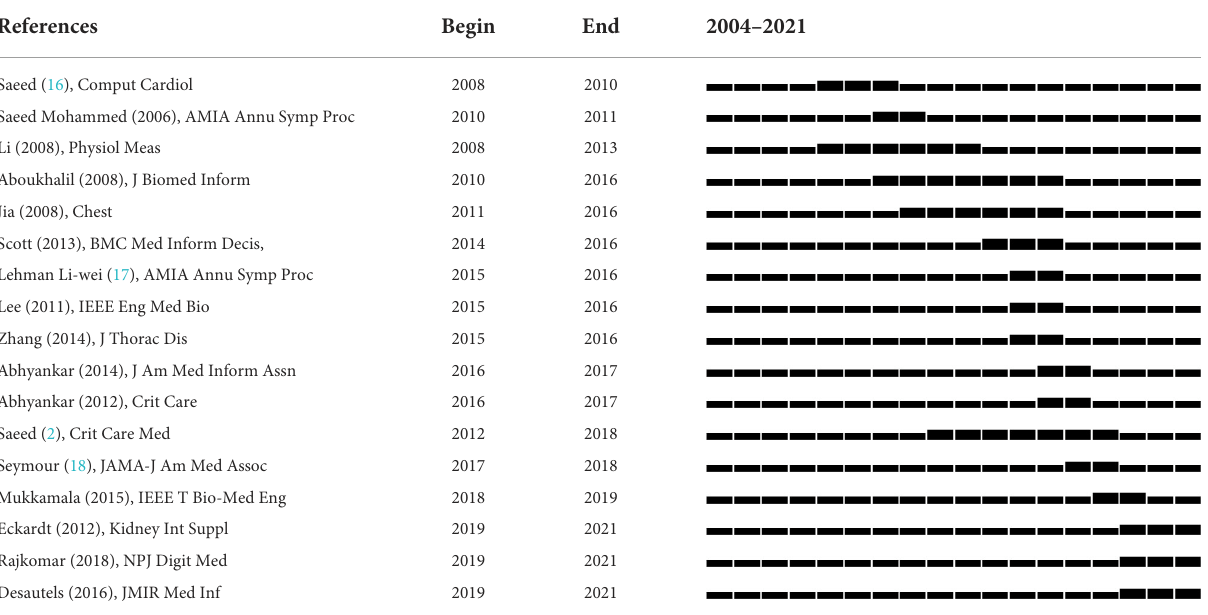
TABLE 6 Top 17 references with the strongest citation